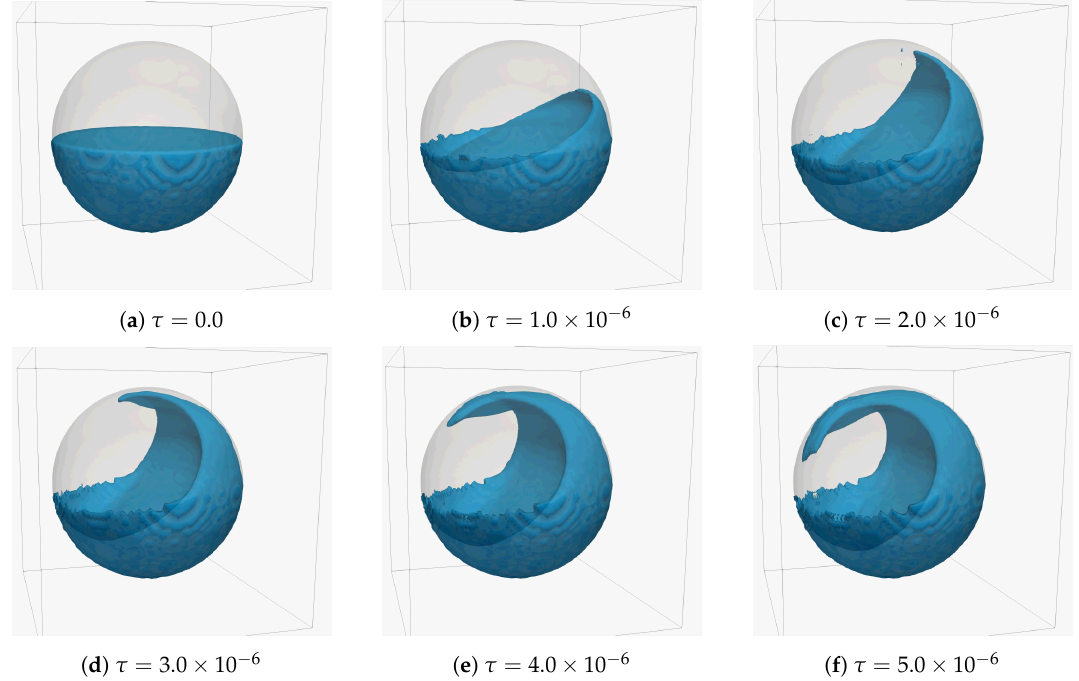
Figure 9. Computational results of Case 0 (no coil). The color indicates liquid phase in the spherical